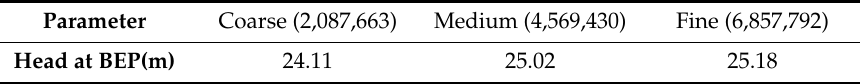
Table 2. Mesh independence study. BEP: Best efficiency point.